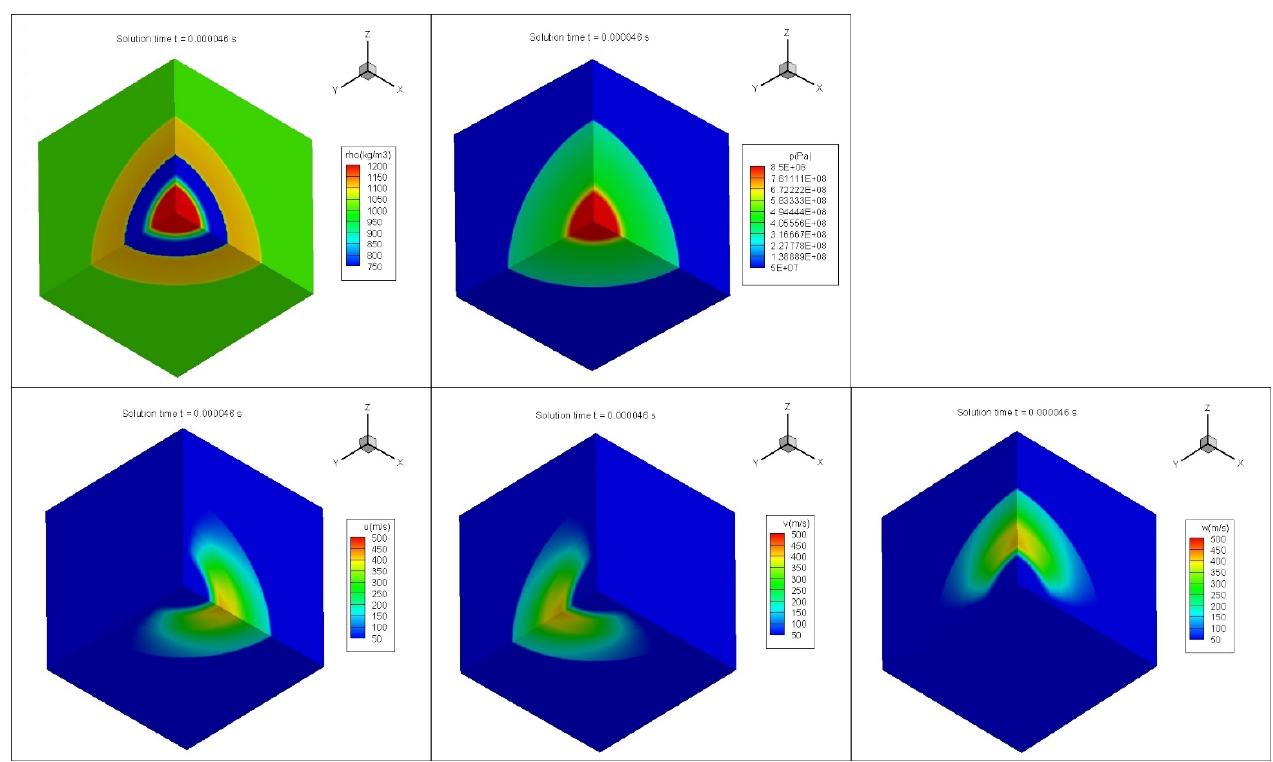
Figure 18. Solution at 4.55 × 10 − 5 s using a 3D third-order solver ( top left : density; top right : pressure; bottom : velocities in the x, y and z directions from left to right ).